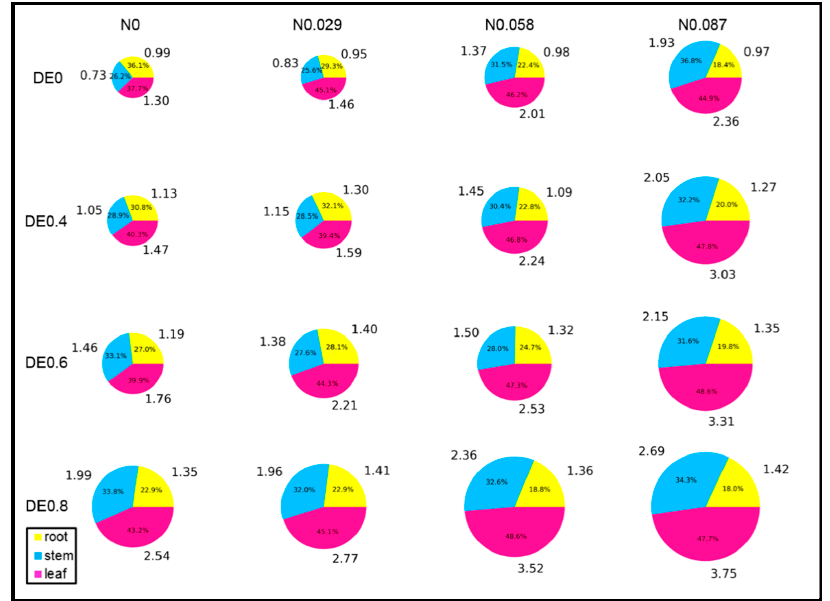
Figure 5. Effects of DewEco (DE) and N fertilizer on N content in the roots, stems and leaves of maize plants. Values inside the pie chart indicate the percentage of N content in each tissue as a percentage of whole plant level, and values outside the pie chart indicate the exact N contents in each plant part as mg g − 1 dry weight. The area of the pie chart represents the total N content of the whole plant under different DewEco and N dosages. Note that, during the drawing process, the experimental data was divided by 4.